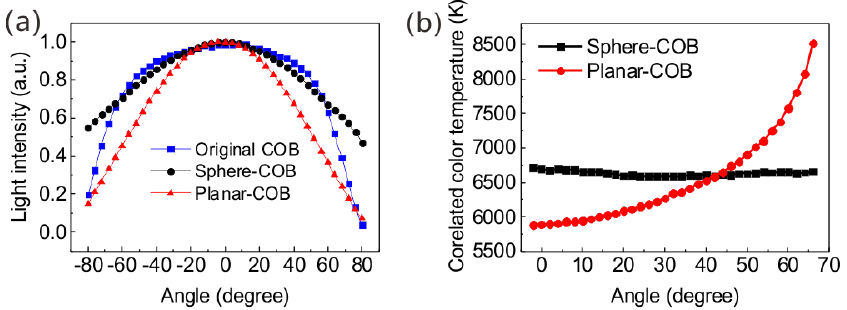
Figure 3. ( a ) Normalized light intensity distribution of the three COBs; ( b ) The angular-dependent CCT of the sphere-COB and planar-COB.